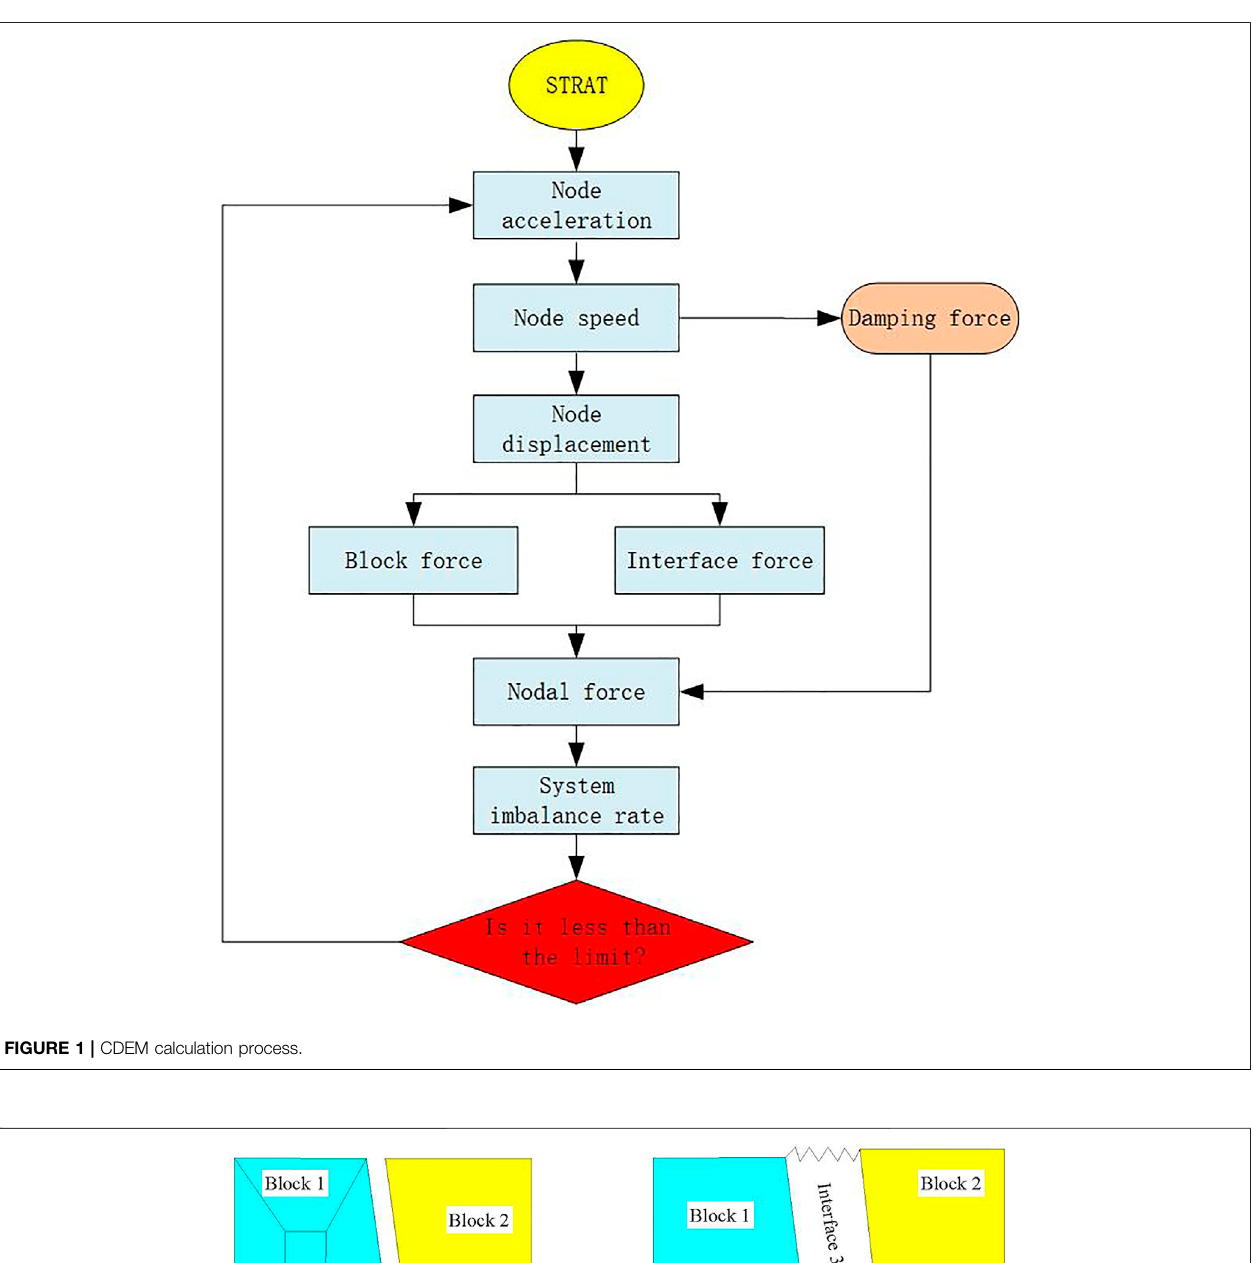
FIGURE 1 | CDEM calculation process.